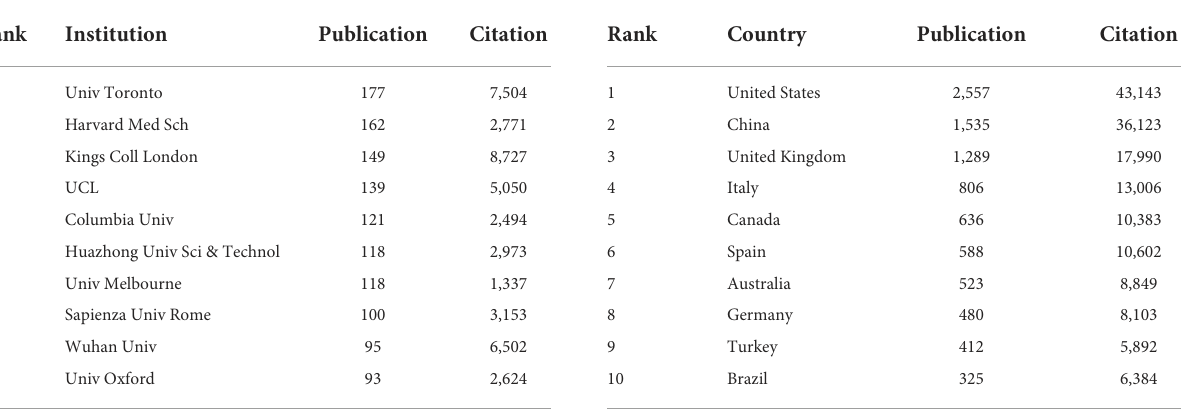
TABLE 3 Top 10 institutions ranked by number of publications. TABLE 4 Top 10 countries ranked by number of